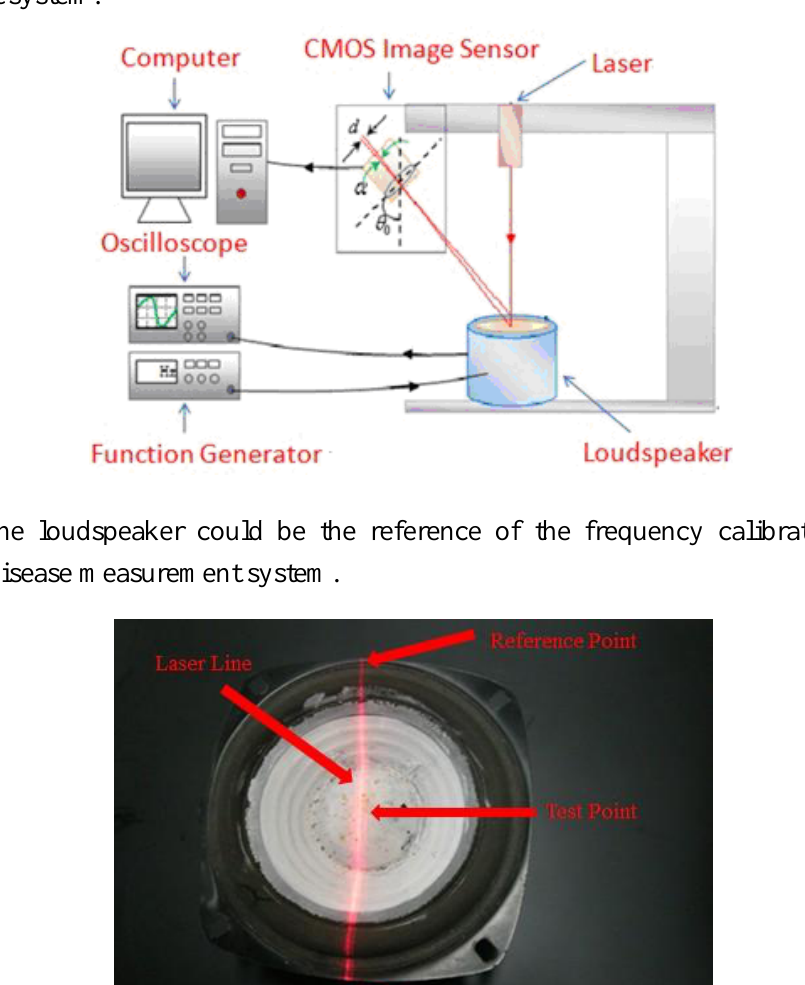
Figure 6. Schematic drawing of frequency calibration for the Parkinson’s disease vibration measurement system.